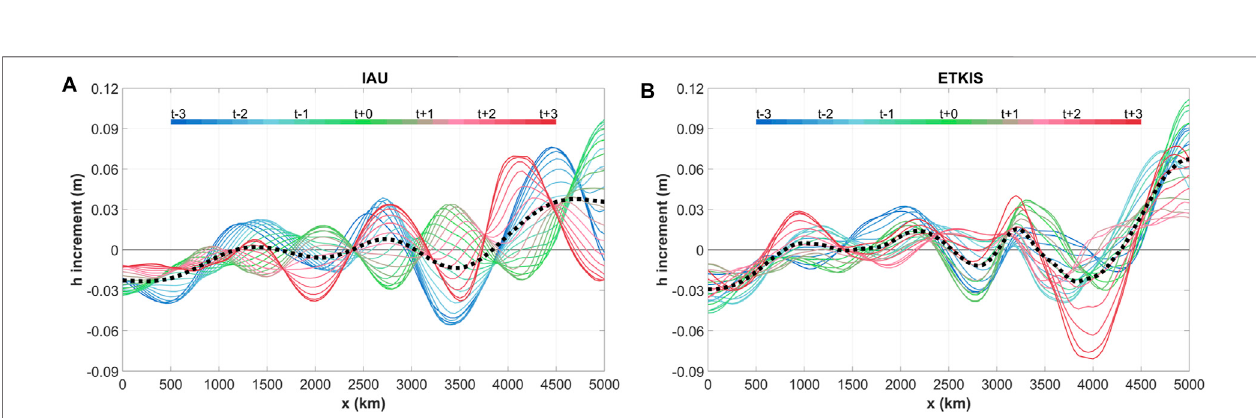
FIGURE4| Thehincrementatt+3(i.e.,9thhour)forgradualincrementaddedduringtheupdatewindowfromt − 3tot+3(3rdhourto9thhour)with (A) IAUand (B) ETKIS schemes. The black dot line is average of the h increments at t − 3.